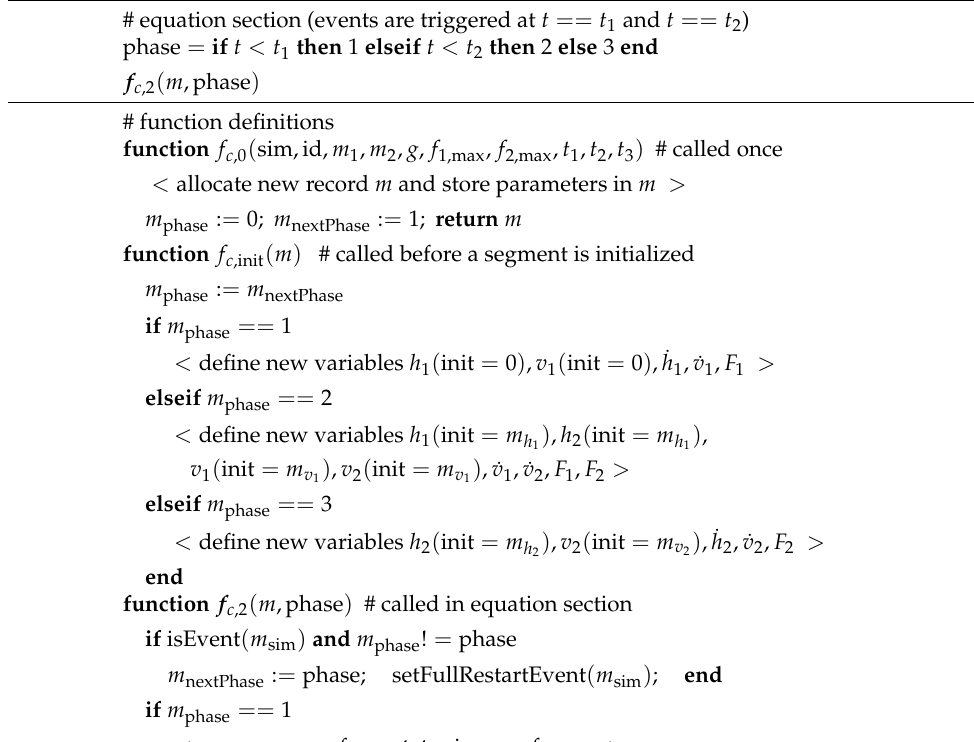
Table A2. Pseudo-code for variable structure state handling of built-in component TwoStageRocket. # equation section (events are triggered at t == t 1 and t == t 2